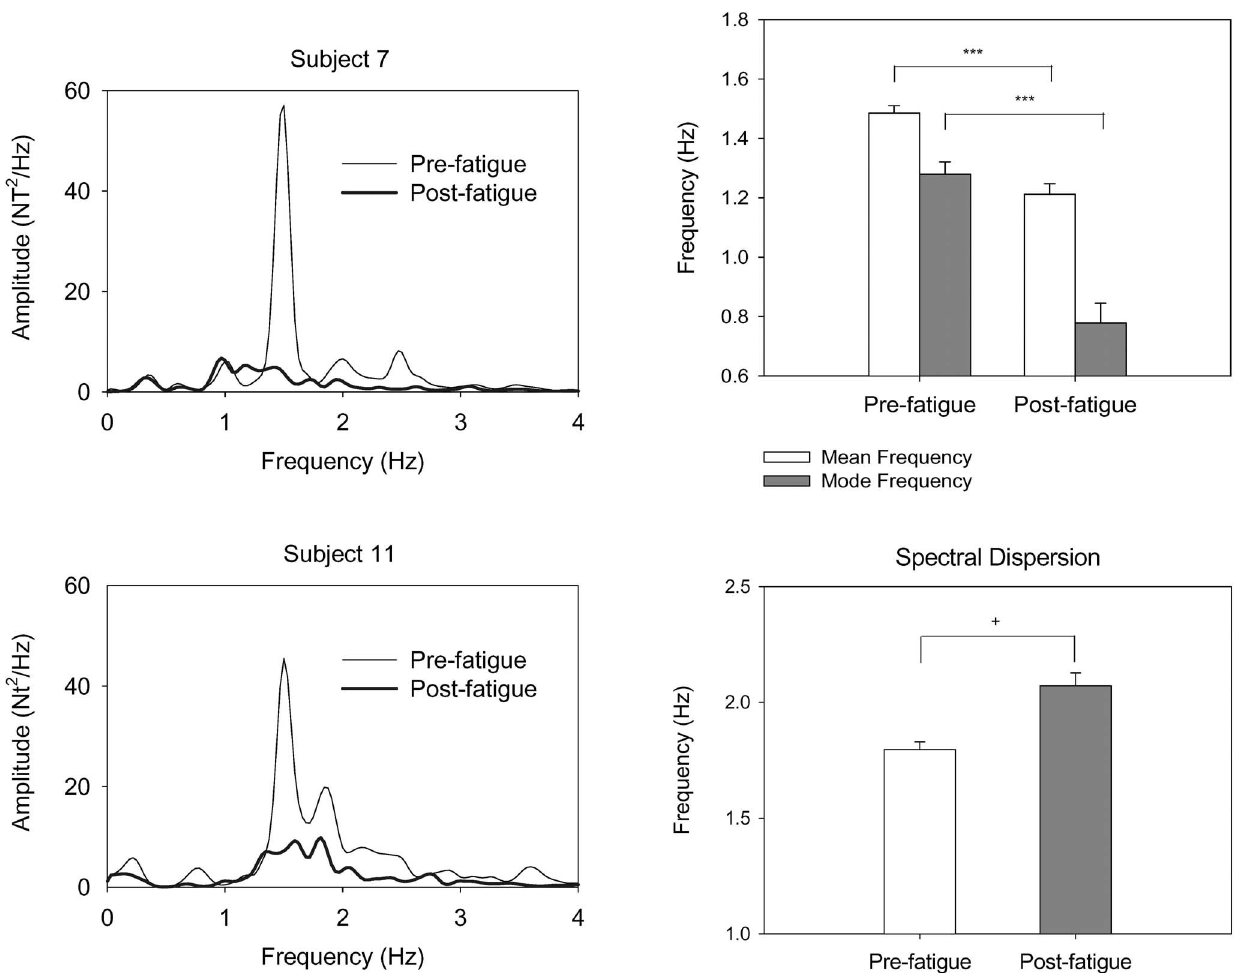
Figure 2. Contrasts of spectral features of force pulse trace between the pre-fatigue and post-fatigue tests. Spectral profiles of force pulse trace for two typical subjects are shown in the left plots. Fatigue effect on mean frequency, mode frequency and spectral dispersion of force pulse trace is summarized in the right plots. ( *** : Post-fatigue , Pre-fatigue, P , .001; { : Post-fatigue . Pre-fatigue, P , .05).